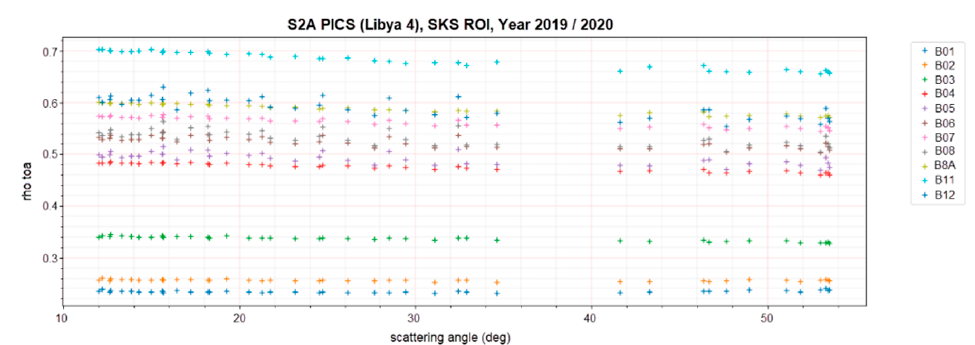
Figure 8. Input data for the BRDF modeling of Sentinel-2A time series.